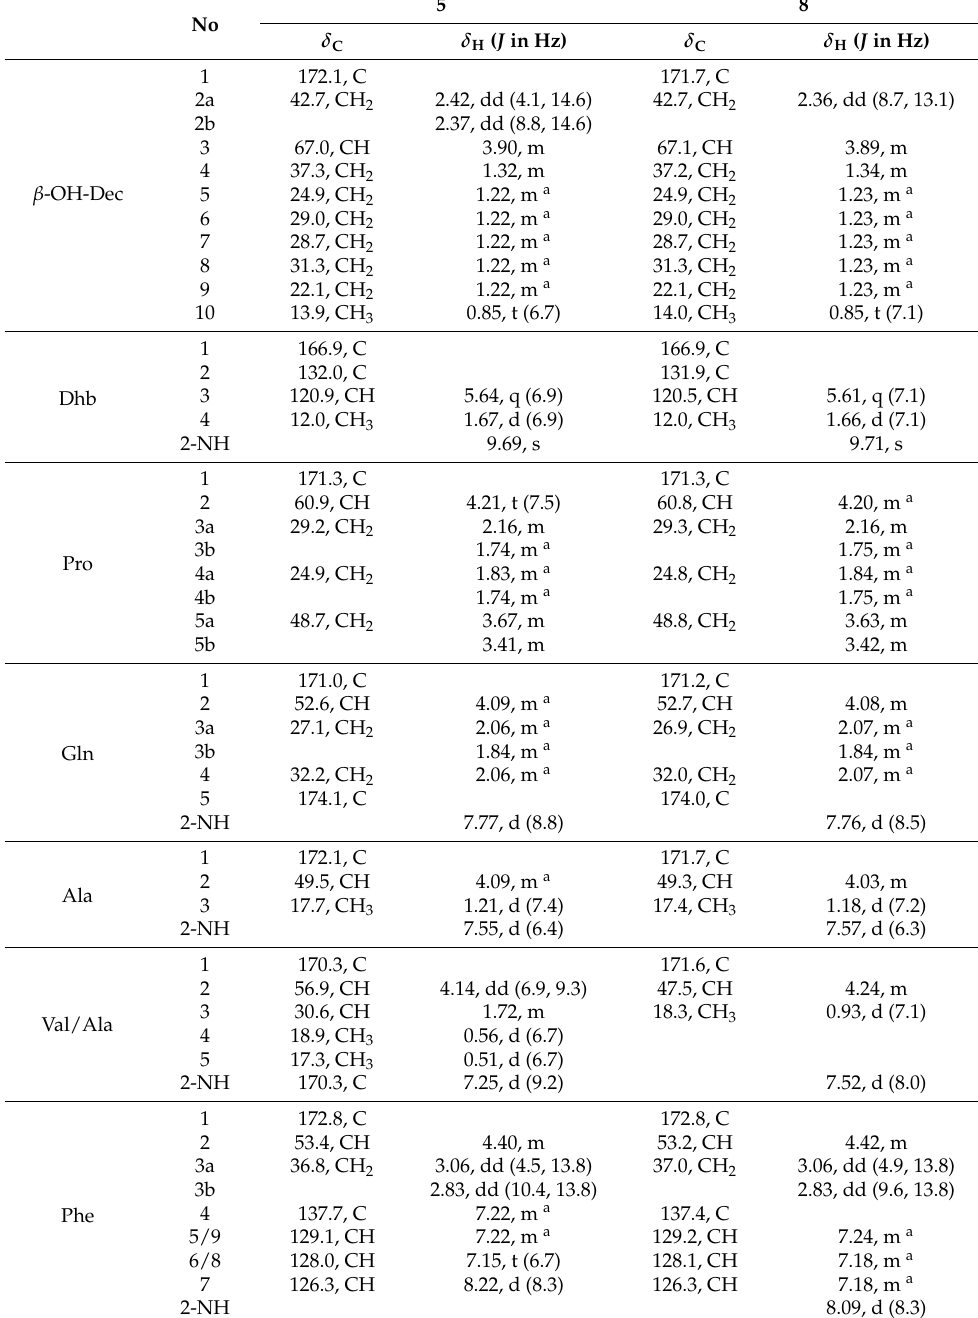
Table 3. The 1 H (500 MHz) and 13 C NMR (125 MHz) data of 5 and 8 in DMSO- d 6.